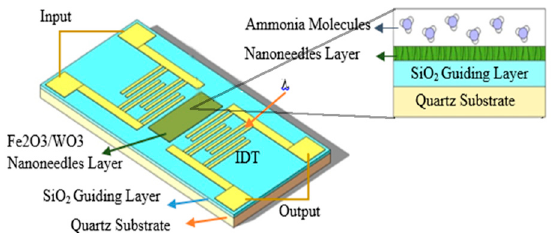
Figure 1. Scheme representing a Love-wave sensor, layer composition.